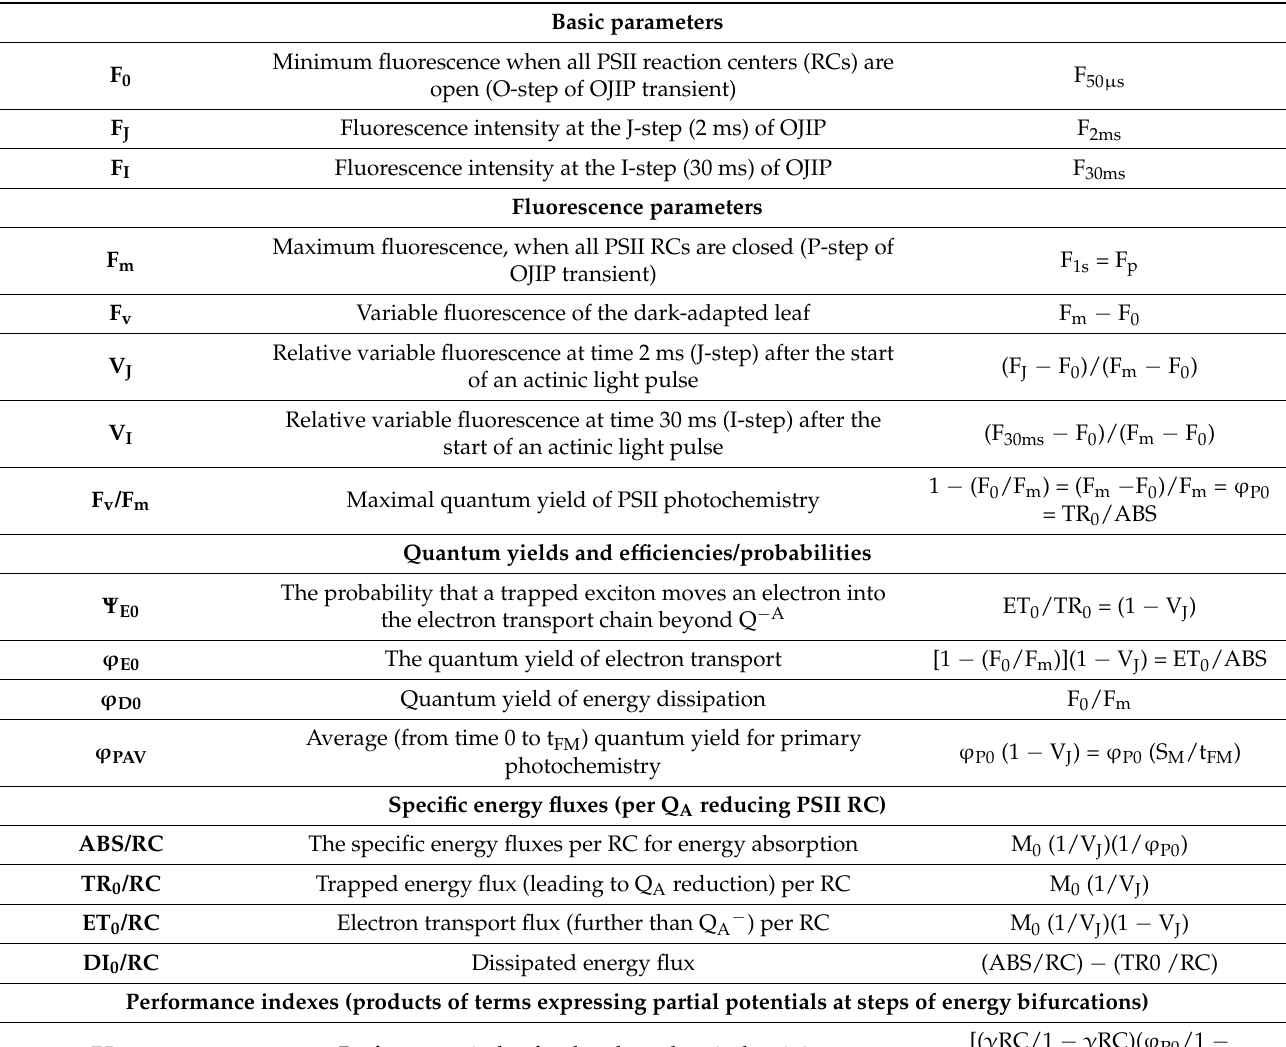
PI ABS Performance index for the photochemical